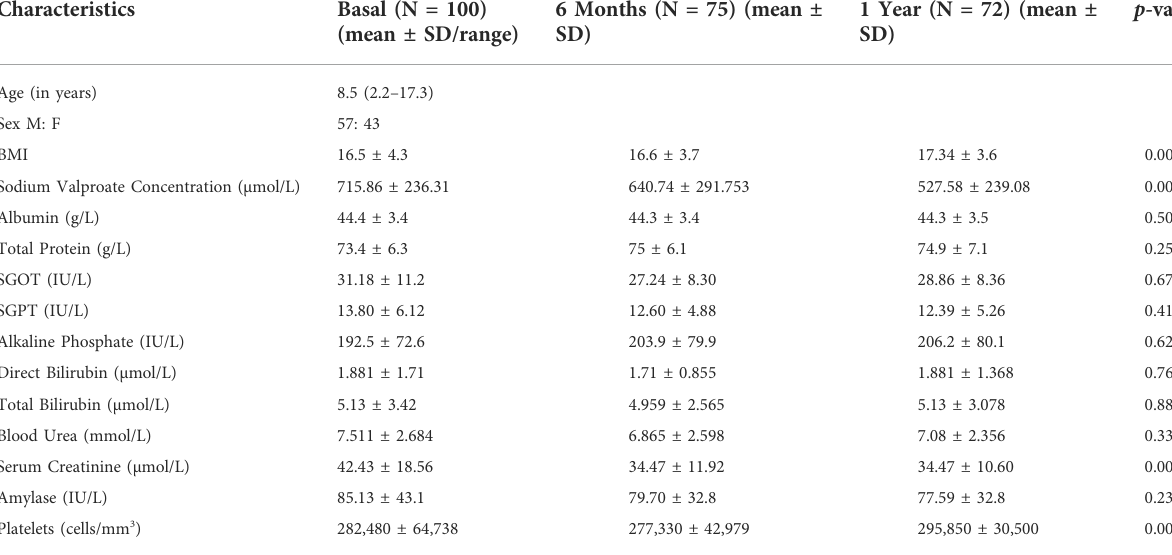
TABLE 4 Comparison of biochemical and hematological parameters at different time intervals. Characteristics